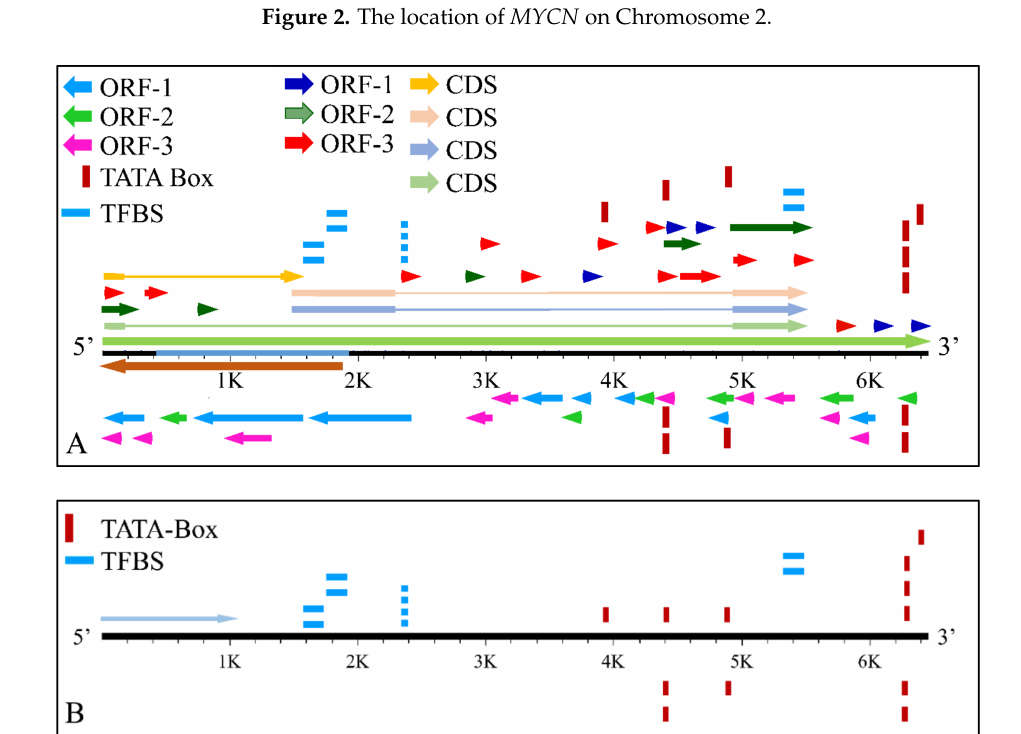
Figure 3. The analysis of the MYCN gene with its complete anatomy ( A ) and the TATA boxes ( B ) (ORF: open reading frame, TFBS: transcription factor binding site, CDS: gene coding